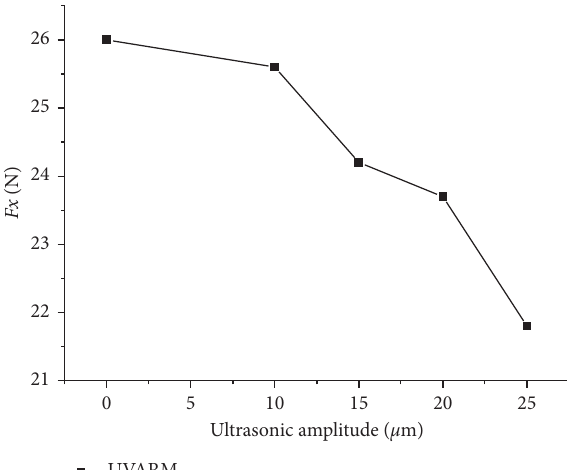
Figure 20: F changes with ultrasonic